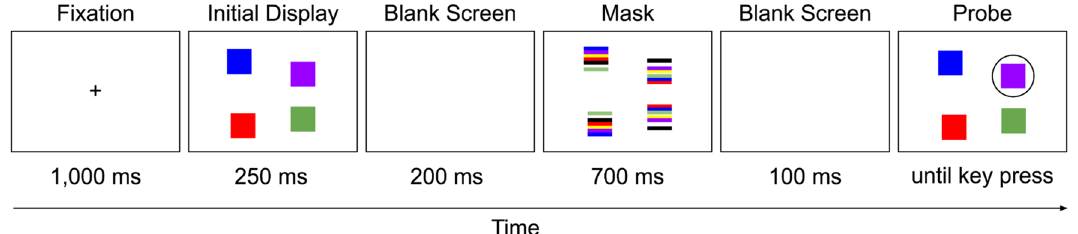
Figure 1. A sample trial of the change-detection training task. Participants were asked to focus on a fixation cross, which was then replaced by a set of colored squares (shown here with set size four). After a blank screen, followed by a mask, followed by another blank screen, a probe of colored squares was presented. Participants had to indicate whether or not the encircled square was of the same color as the one in the initial